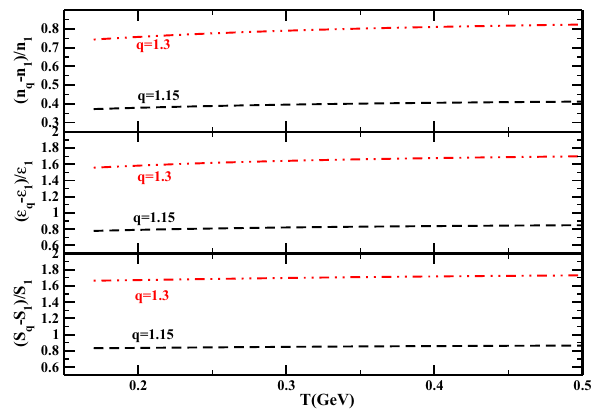
Fig. 5 Relative ratios of the non-extensive correction to the q = 1 values of the thermodynamic quantities